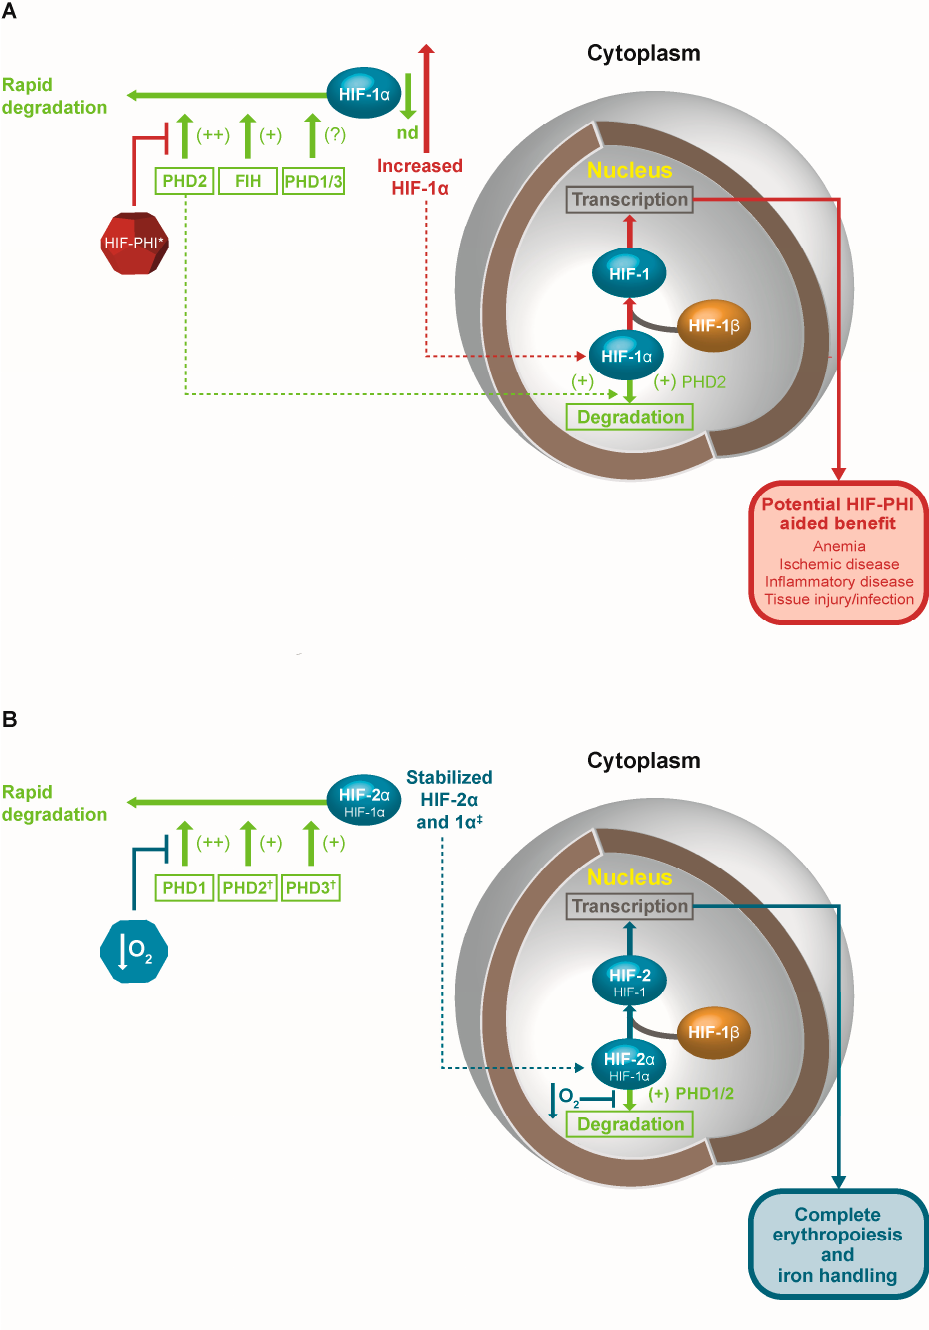
Figure 1. Primary hypoxia-inducible factor (HIF) intracellular distribution and key points of action in ( A ) Normoxia and ( B ) Hypoxia. Green arrows and text represent pathways of degradation of HIF. Red arrows and text represent effect of HIF-PHI, while blue arrows and text represent effect of hypoxia. T-bar represents inhibition of a pathway. Expression: HIF-1 α : ubiquitous tissue expression; HIF-2 α : brain, heart, lung, kidney, liver, pancreas, and intestine; HIF-3 α : heart, lung, and kidney. Specificity: PHD2 and FIH, HIF-1 α ; PHD1 and PHD3, HIF-2 α . * Effect of HIF-PHI on FIH unclear. Dotted lines represent translocation to nucleus. † PHD2 and PHD3 upregulated by hypoxia as part of a counter-regulatory mechanism. ‡ In certain situations, HIF-1 α controls the early response to hypoxia. FIH: factor inhibiting HIF; HIF-PHI: hypoxia inducible factor-prolyl hydroxylase inhibitor; nd: not detectable; PHD: prolyl-hydroxylase domain.